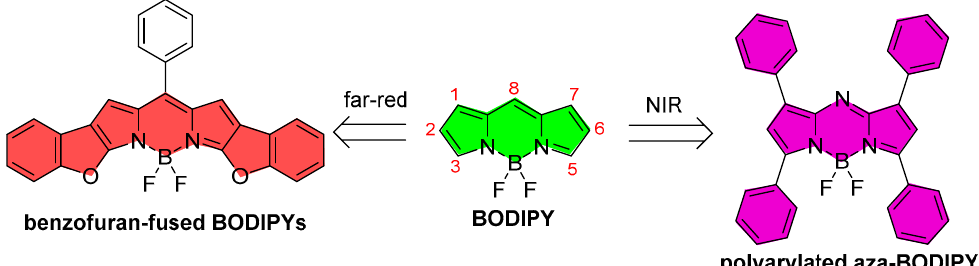
Figure 2. Molecular structure of the renowned boron-dipyrromethene (BODIPY) chromophore and the chemical modification carried out to push the spectral bands toward the red edge of the visible spectrum and NIR